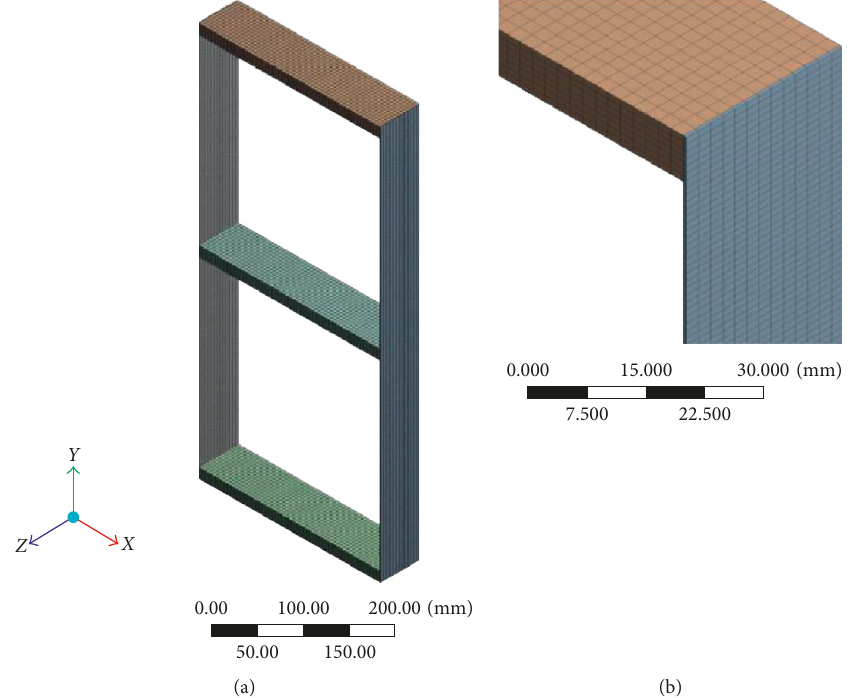
Figure 3: (a) The mesh of the physical model and (b) detail of the mesh in the columns.